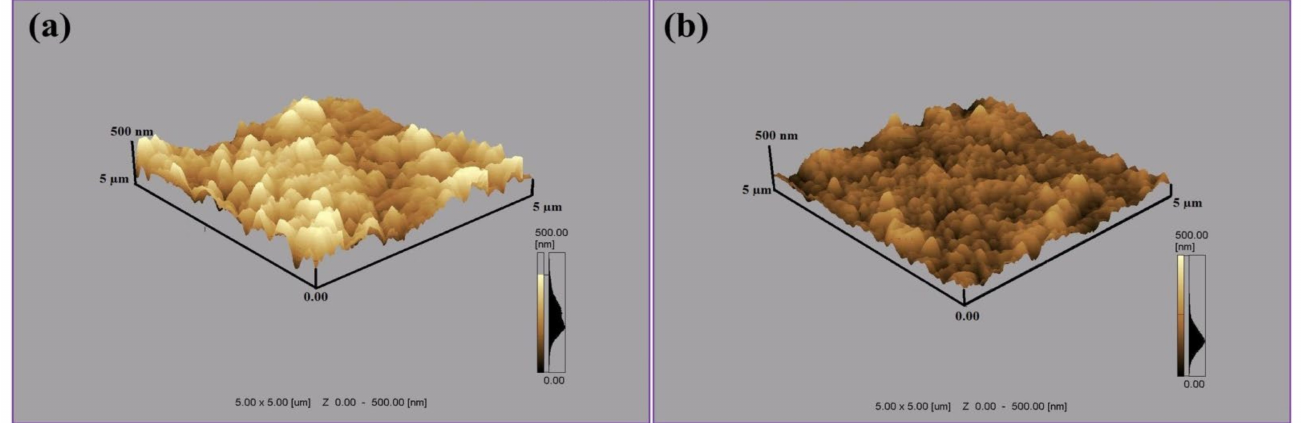
Figure 6. AFM surface topographical images of Al targets exposed to 100 pulses of Excimer laser at a wavelength of 248 nm, pulse duration of 18 ns and for a laser fluence of 0.86 J · cm − 2 , in ambient environments of ( a ) Ar and ( b ) O 2 at a pressure of 100